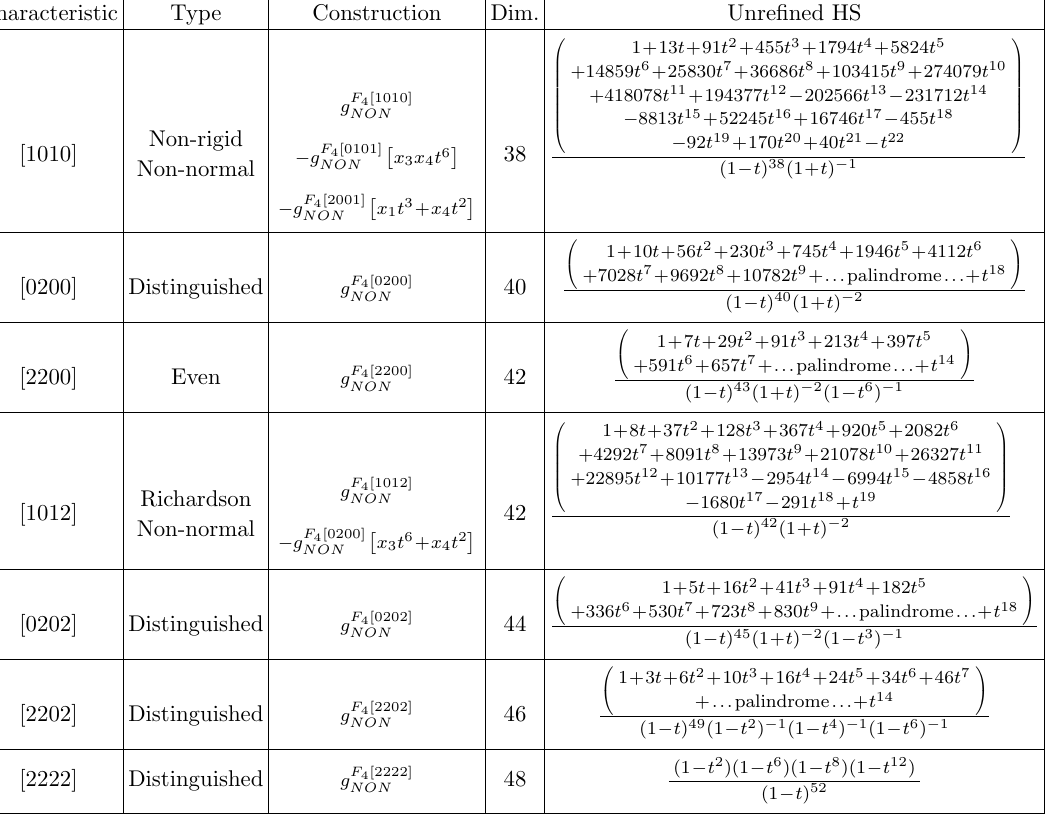
Table 7 . F 4 orbit constructions and Hilbert series